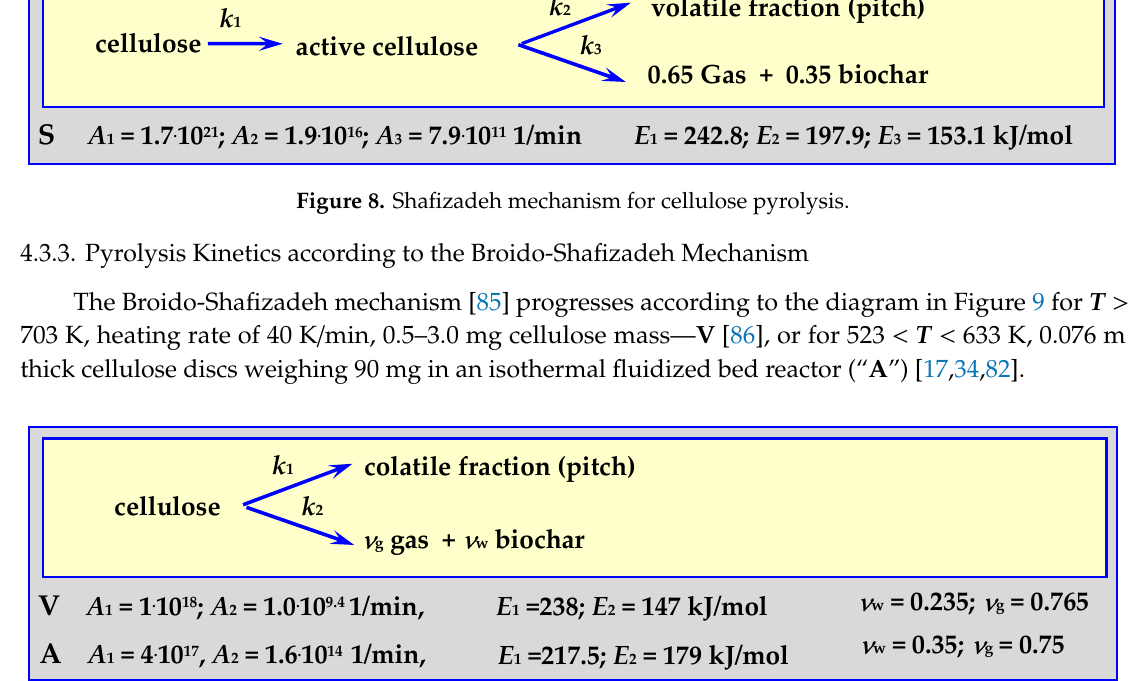
Figure 9. Broido-Shafizadeh mechanism for cellulose pyrolysis.